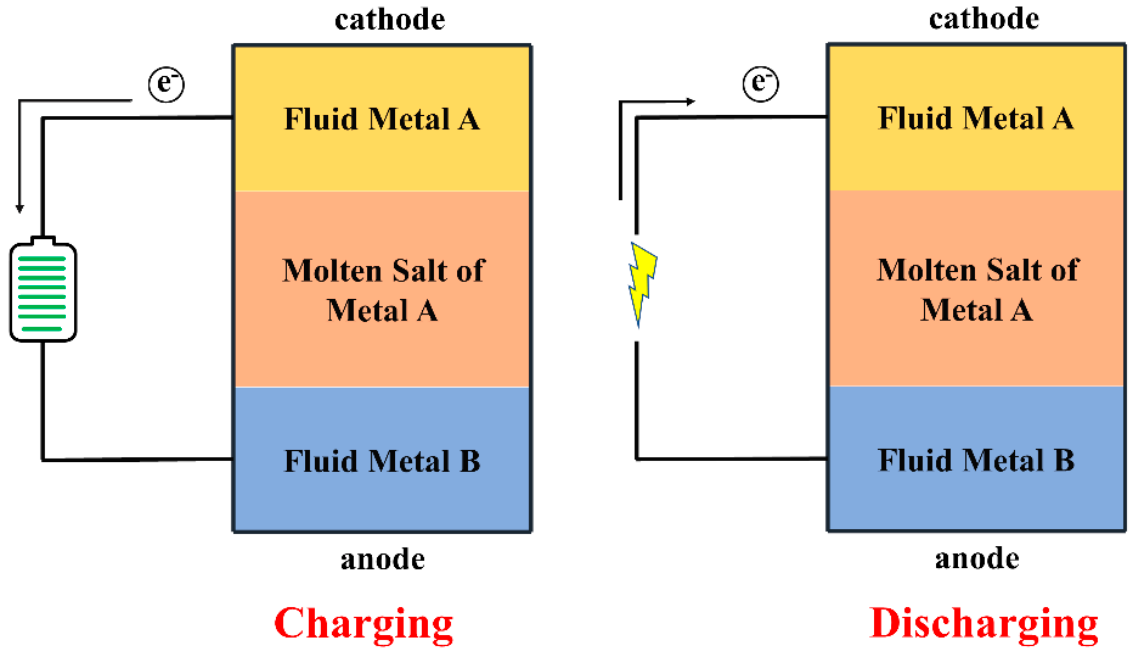
Figure 2. Charge and discharge processing of liquid metal battery.